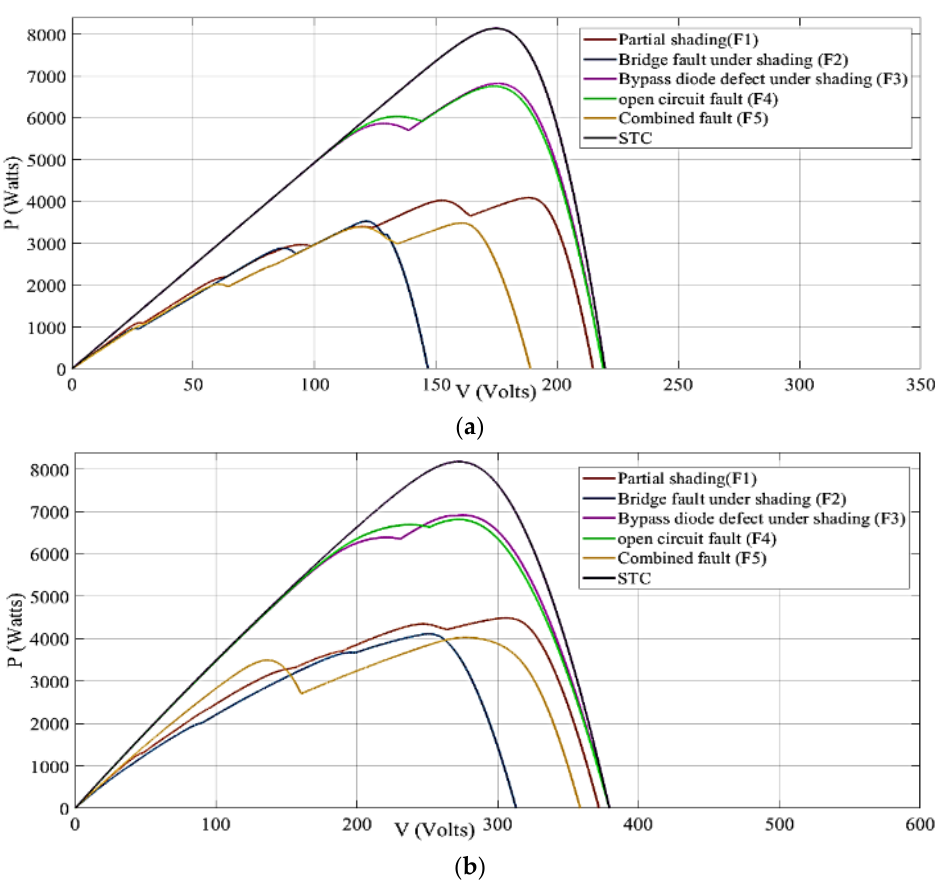
Figure 6. Fault States: ( a ) PV curve under various faults (monocrystalline). ( b ) PV curve under various faults (CIGS). Table 7. Simulation results. Table 4. Computed values of PV under various